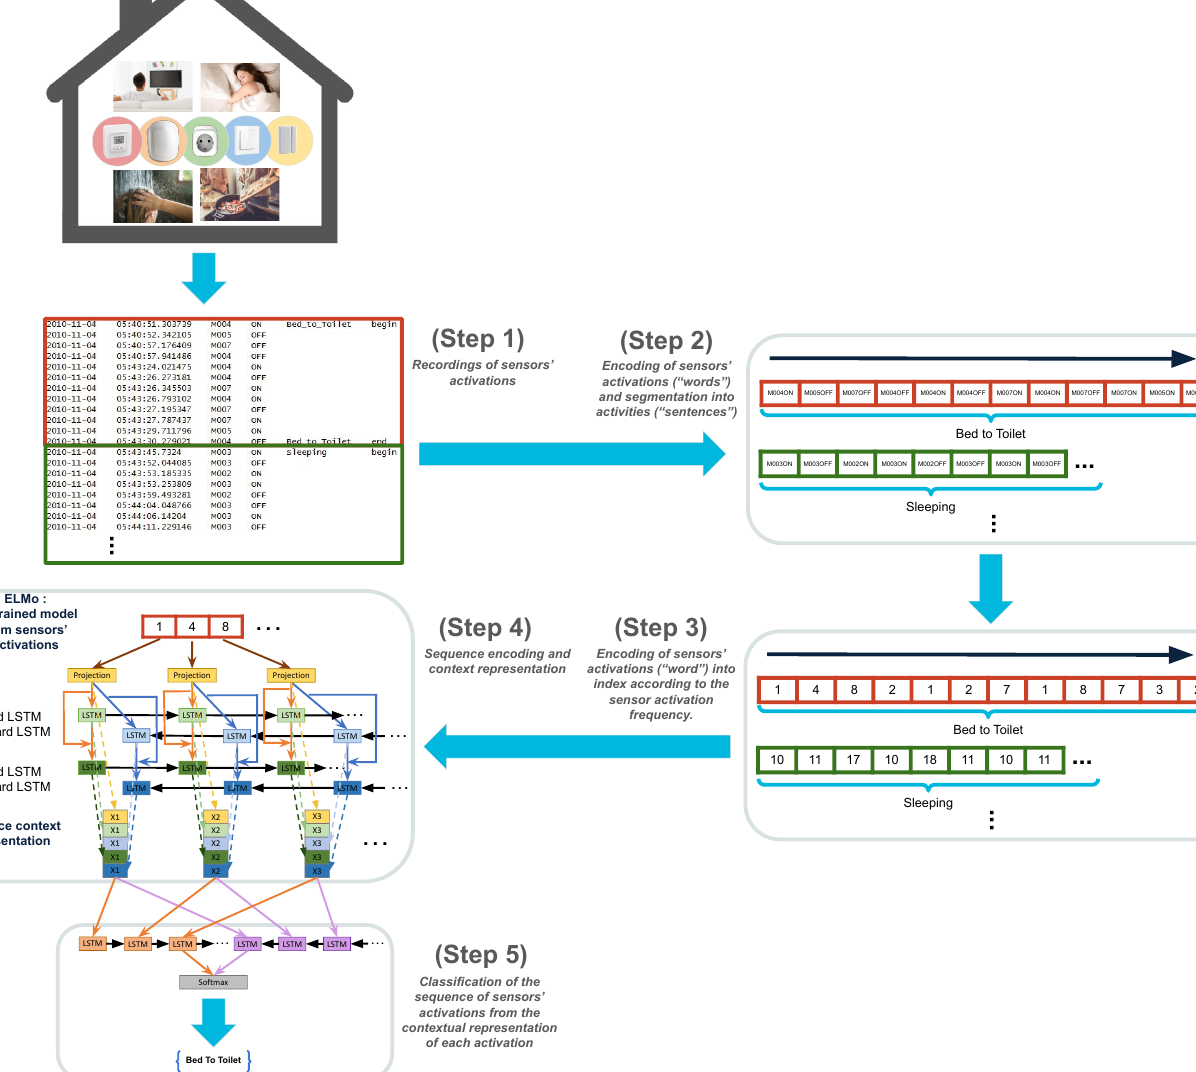
Figure 3. Proposed model architecture and global